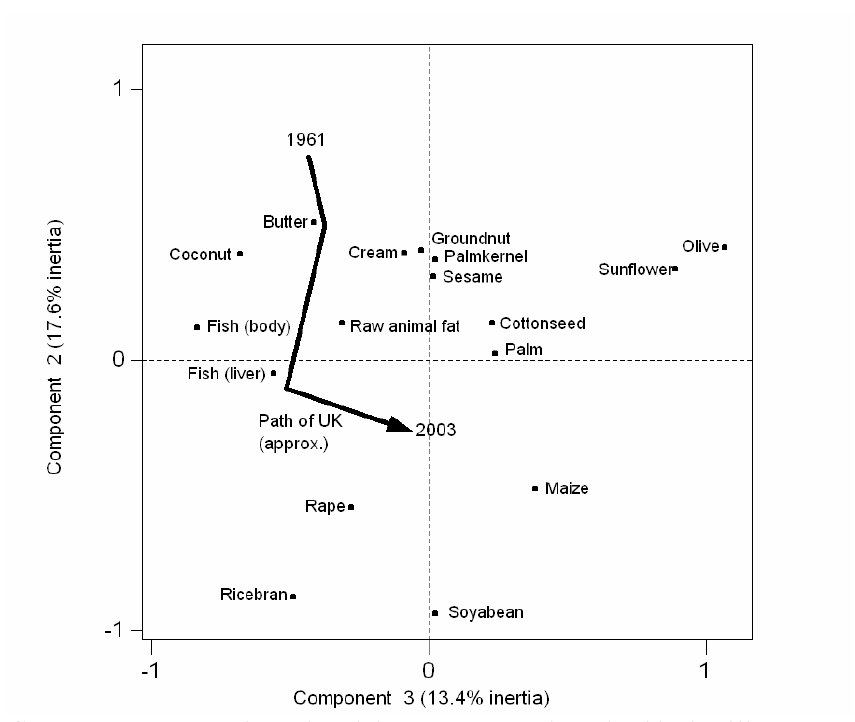
Figure 1a: Correspondence analysis – edible lipids plotted by their availability in different world regions in 1961 and 2003.